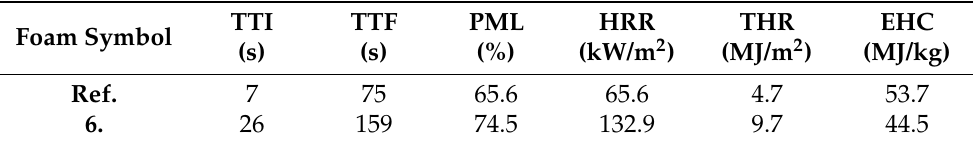
Table 7. The test results of RPUFs using the cone calorimeter.